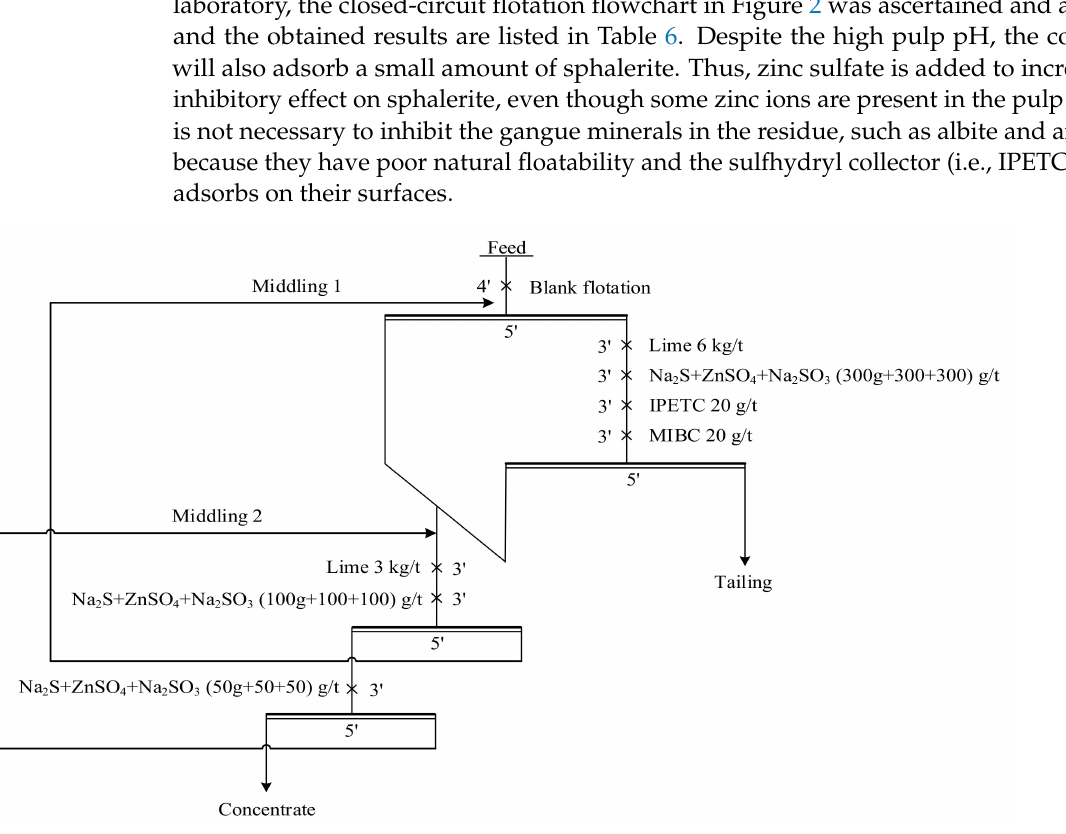
Figure 2. Flowchart of closed-circuit flotation of high-sulfur residue with IPETC, ADDTP and SEX